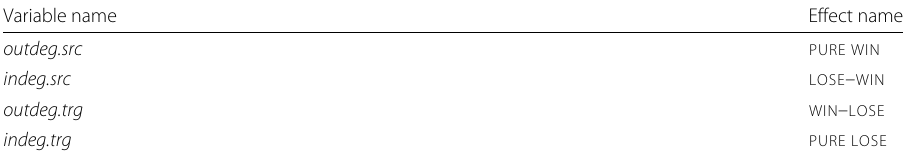
Table 1 Correspondence between variable names and names of degree effects (compare Fig. 1) for undo events and third-party edit events Variable name Effect name outdeg.src PURE WIN indeg.src LOSE – WIN outdeg.trg WIN – LOSE indeg.trg PURE